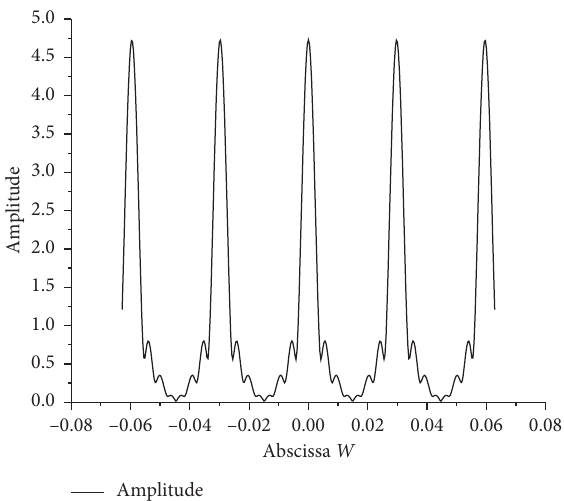
Figure 9: Empirical distribution cumulative failure probability amplitude frequency diagram.